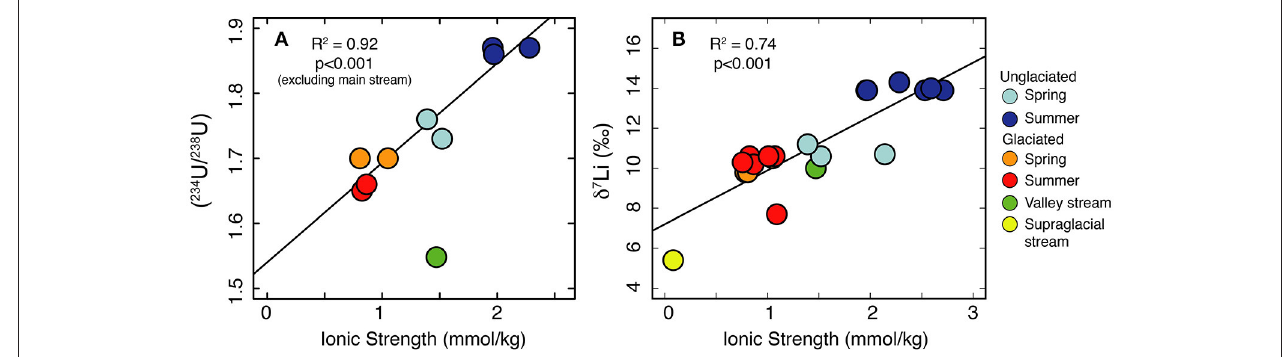
FIGURE 3 | Significant positive trends are observed between ionic strength, a proxy for the amount of chemical weathering, and both ( 234 U/ 238 U) (A) and δ 7 Li ratios (B) .